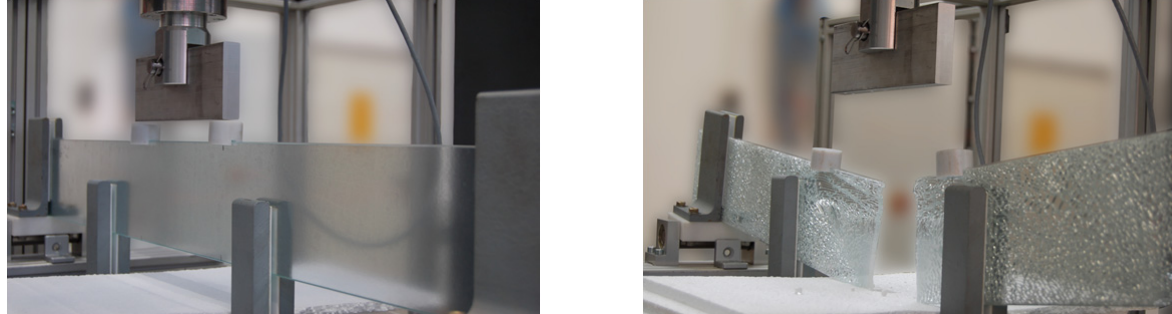
Fig. 4 Test bench with built-in (left) and broken specimen